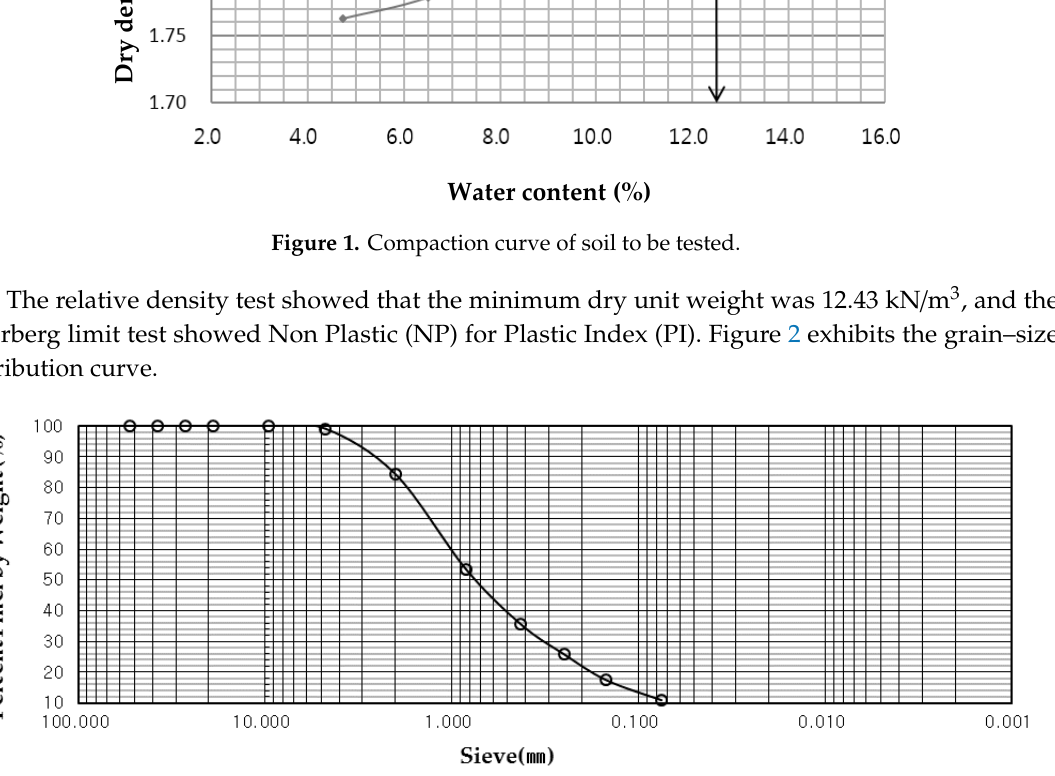
Figure 2. Grain – size distribution curve of soil to be tested. Figure 2. Grain–size distribution curve of soil to be